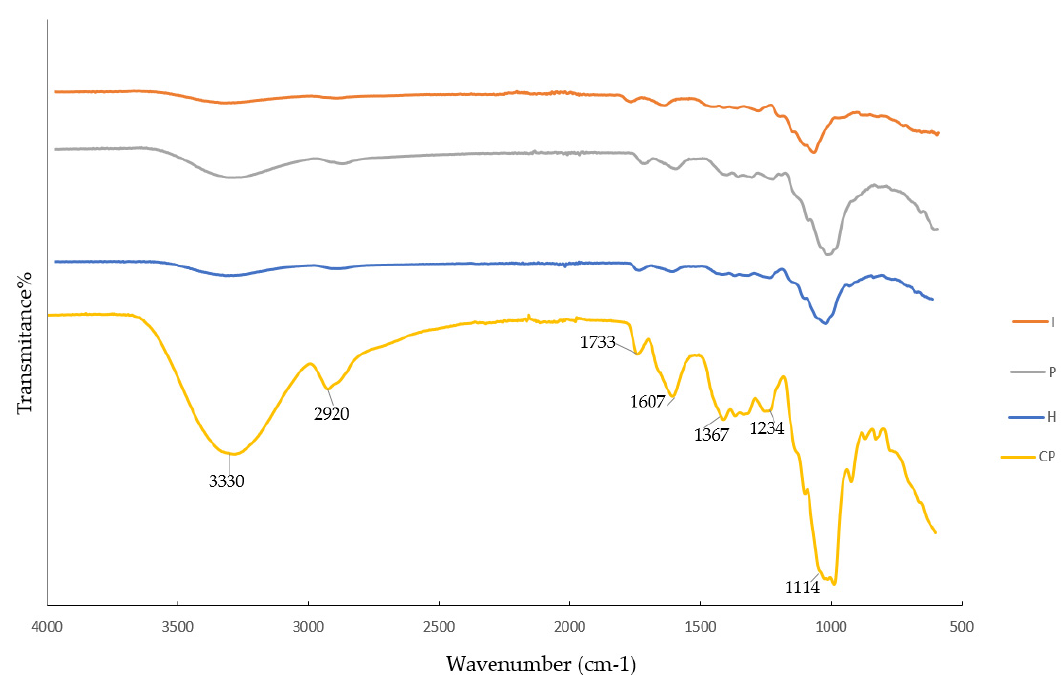
Figure 5. Fourier transform infrared spectroscopy of carrot pomace (CP) and its derivatives after hemicellulase (H), pectinase (P), and invertase (I) pretreatments.